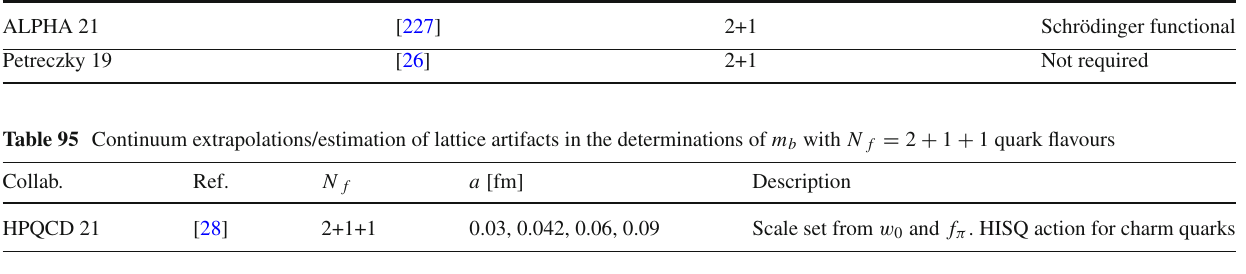
Table 94 Renormalization in the determinations of m c with N f = 2 + 1 quark flavours Collab.